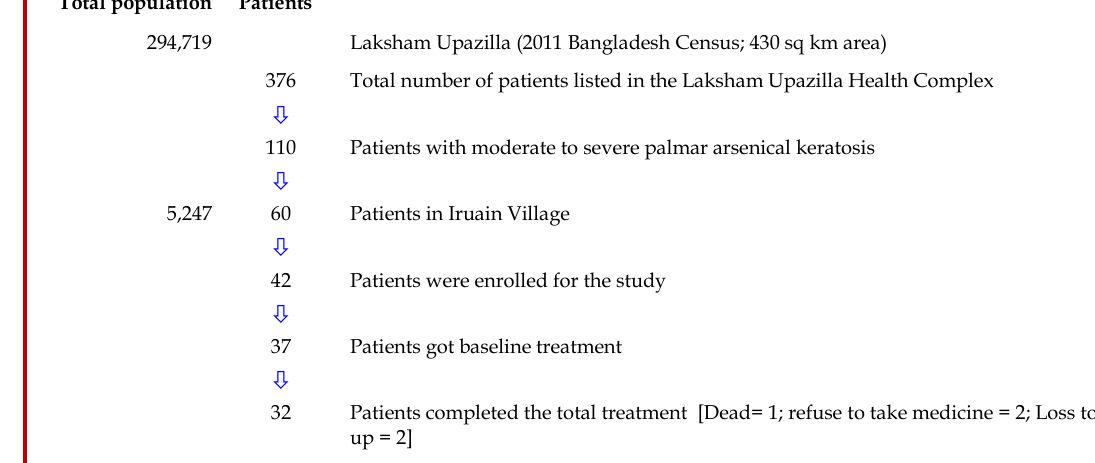
Figure 2: Steps of selection of arsenicosis